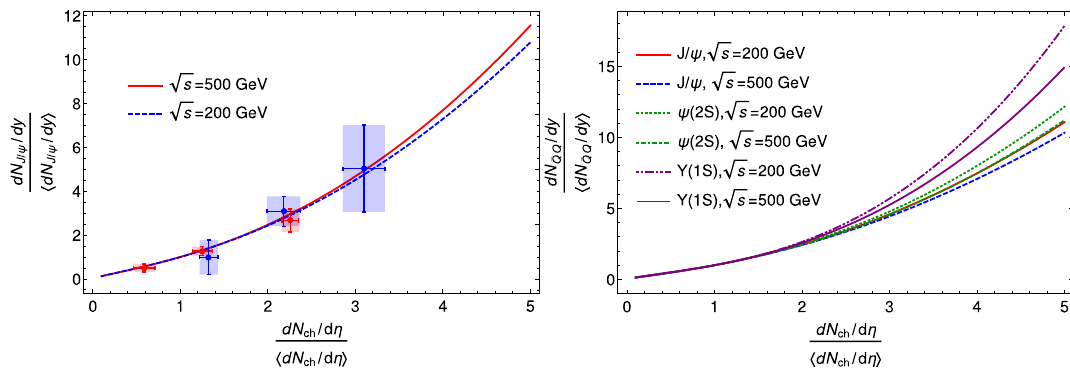
Fig. 8 Left: comparison of model results for the multiplicity with data from [15,16]. Blue points and curves correspond to √ s = 500 GeV. Right: comparison of J /ψ results with predictions for ψ( 2 S ) and Υ ( 1 S points and curves correspond to